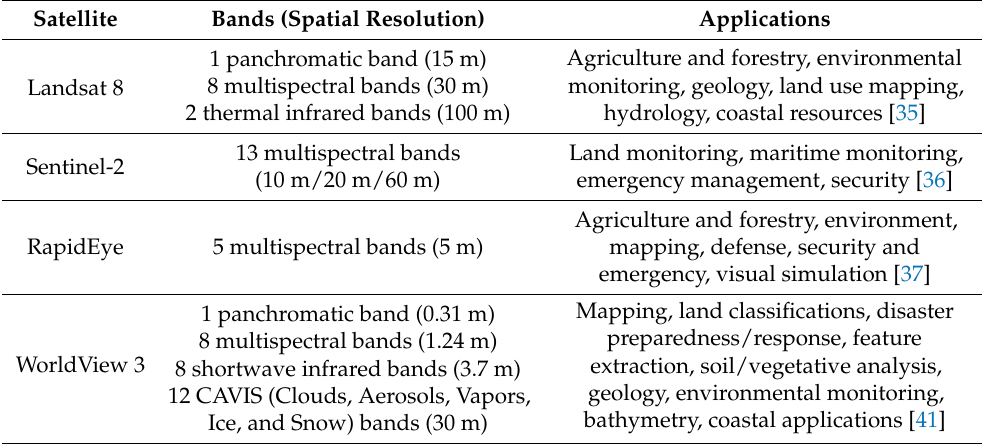
Table 4. Satellites most used in PA and PV with acquired bands, resolutions and applications. Satellite Bands (Spatial Resolution) Applications Agriculture and forestry,